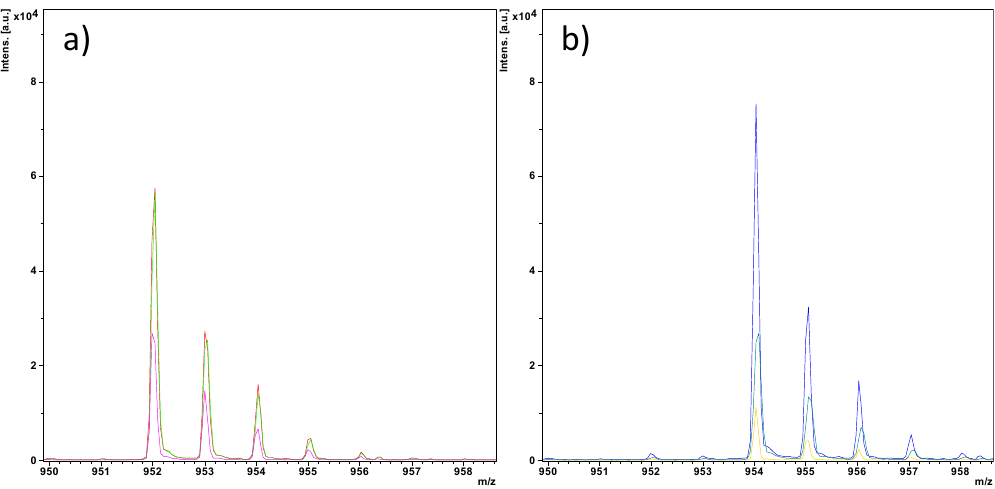
Figure 4. Stability of peptide 8 ([KTVRTSADE]) in pH 7.4 PBS with DTT. The percent remaining was calculated from the AUC.